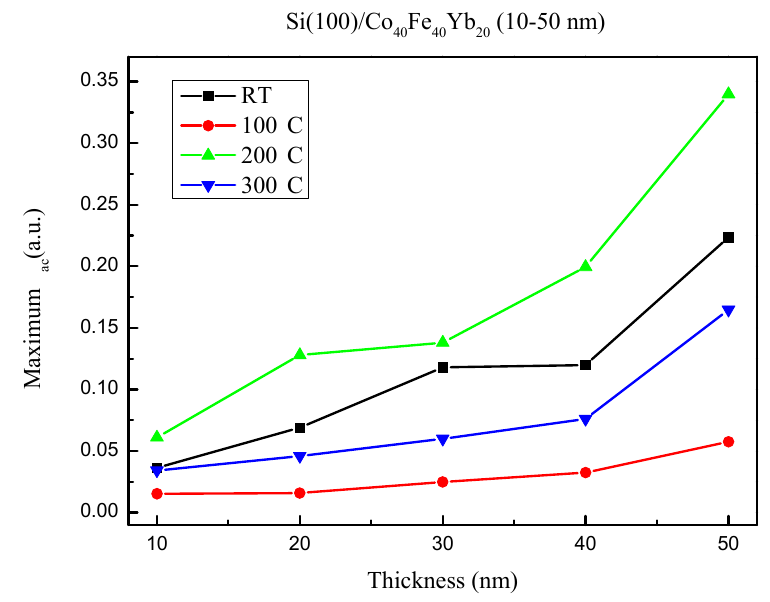
Figure 8. The frequency dependence of alternate-current magnetic susceptibility ( χ ac ) from 50 to 25,000 Hz. ( a ) As-deposited, ( b ) post-annealing at 100 °C, ( c ) post-annealing at 200 °C, and ( d ) post-annealing at 300 °C.